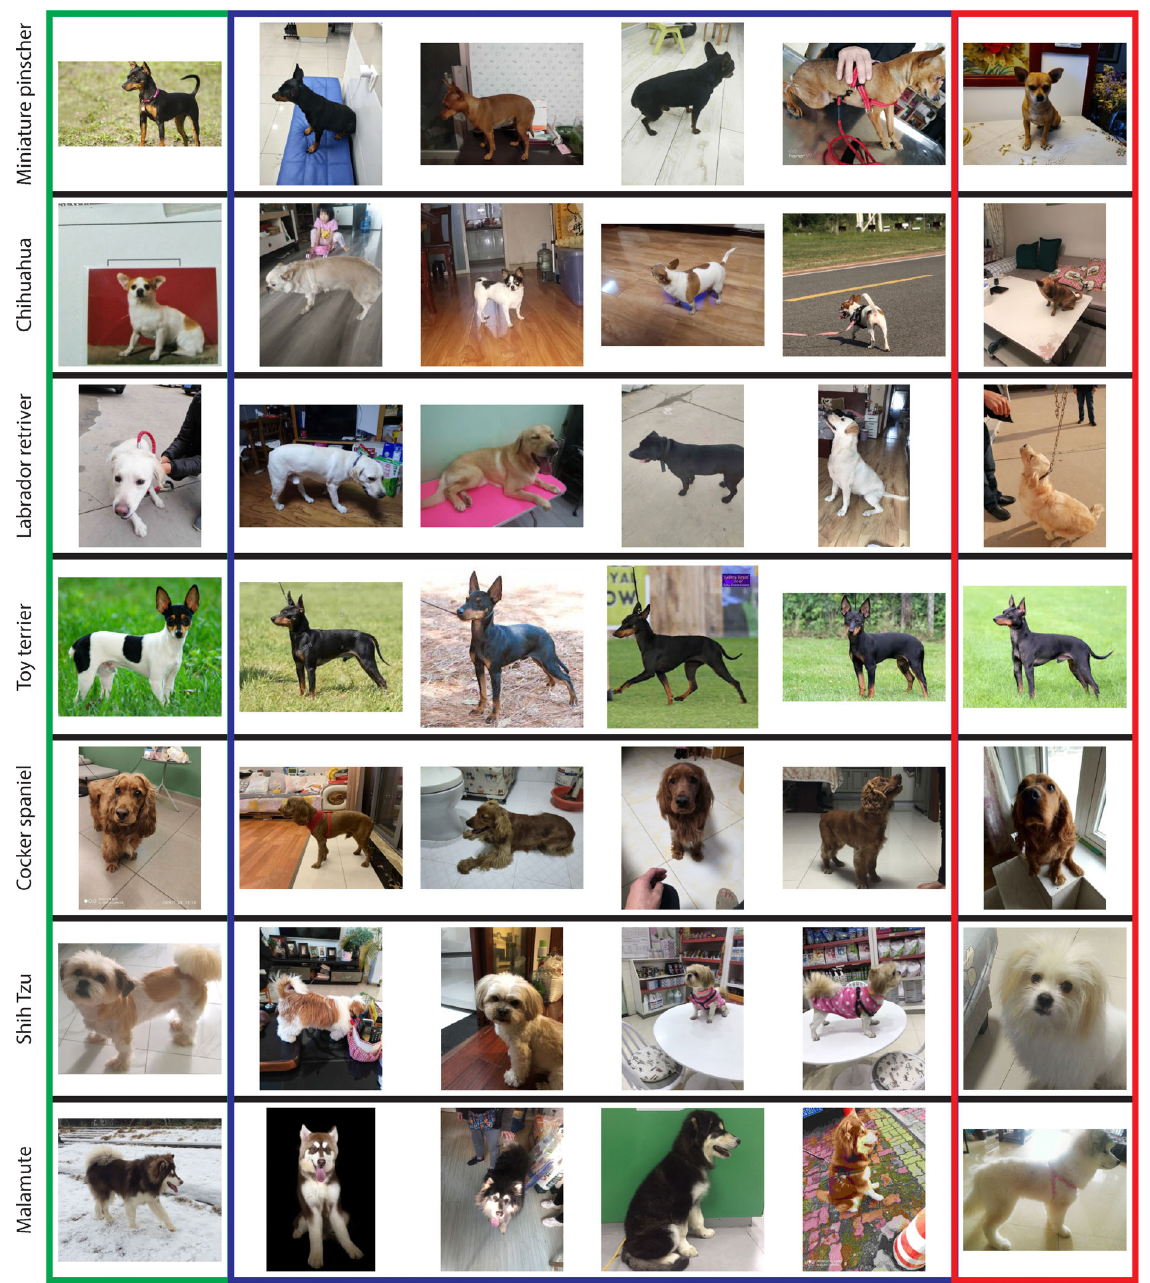
Fig. 12 Qualitative comparison of WS DAN models trained on Stanford Dogs and Tsinghua Dogs. Dogs in each row belong to the same breed. WS DAN trained on Tsinghua Dogs classifies the dogs correctly except for the last column, while the one trained on Stanford Dogs gives a correct classification only for the first